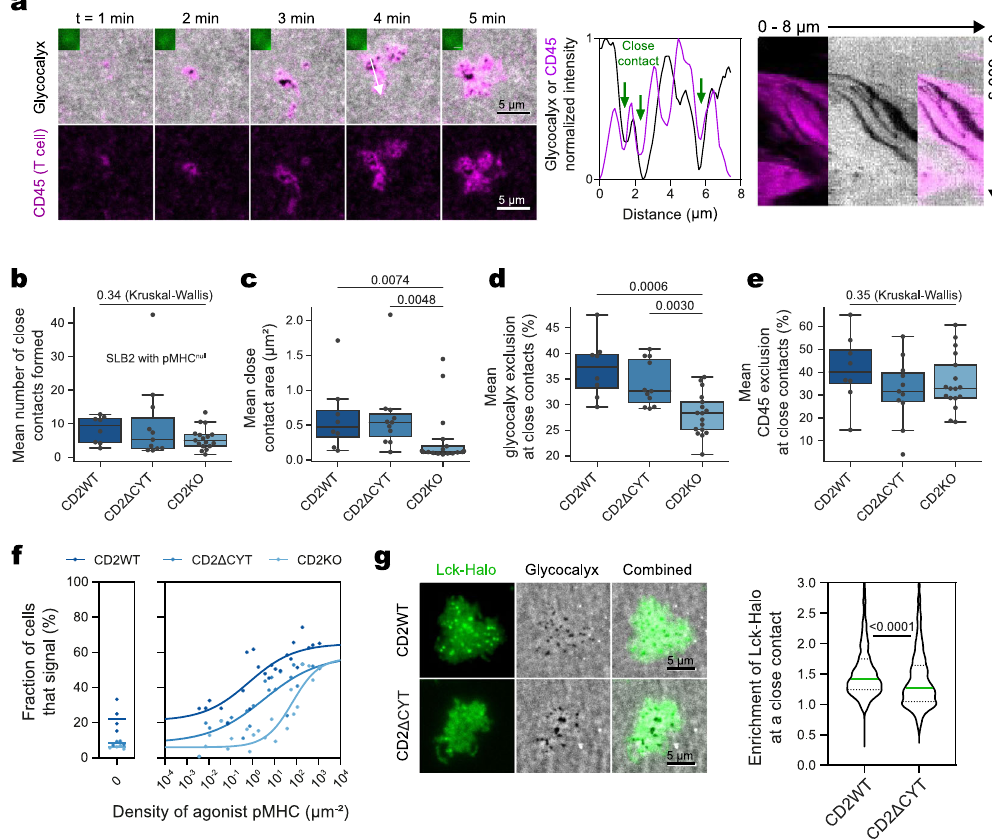
Fig.5|CD2enhancesT-cellsensitivity.a CD45exclusionatclosecontactsformed by J8-GECI-CD2WT cells. The images show a J8-GECI-CD2WT cell during the scan- ning stage on an SLB2 presenting pMHC null ; inset shows GECI fl uorescence,